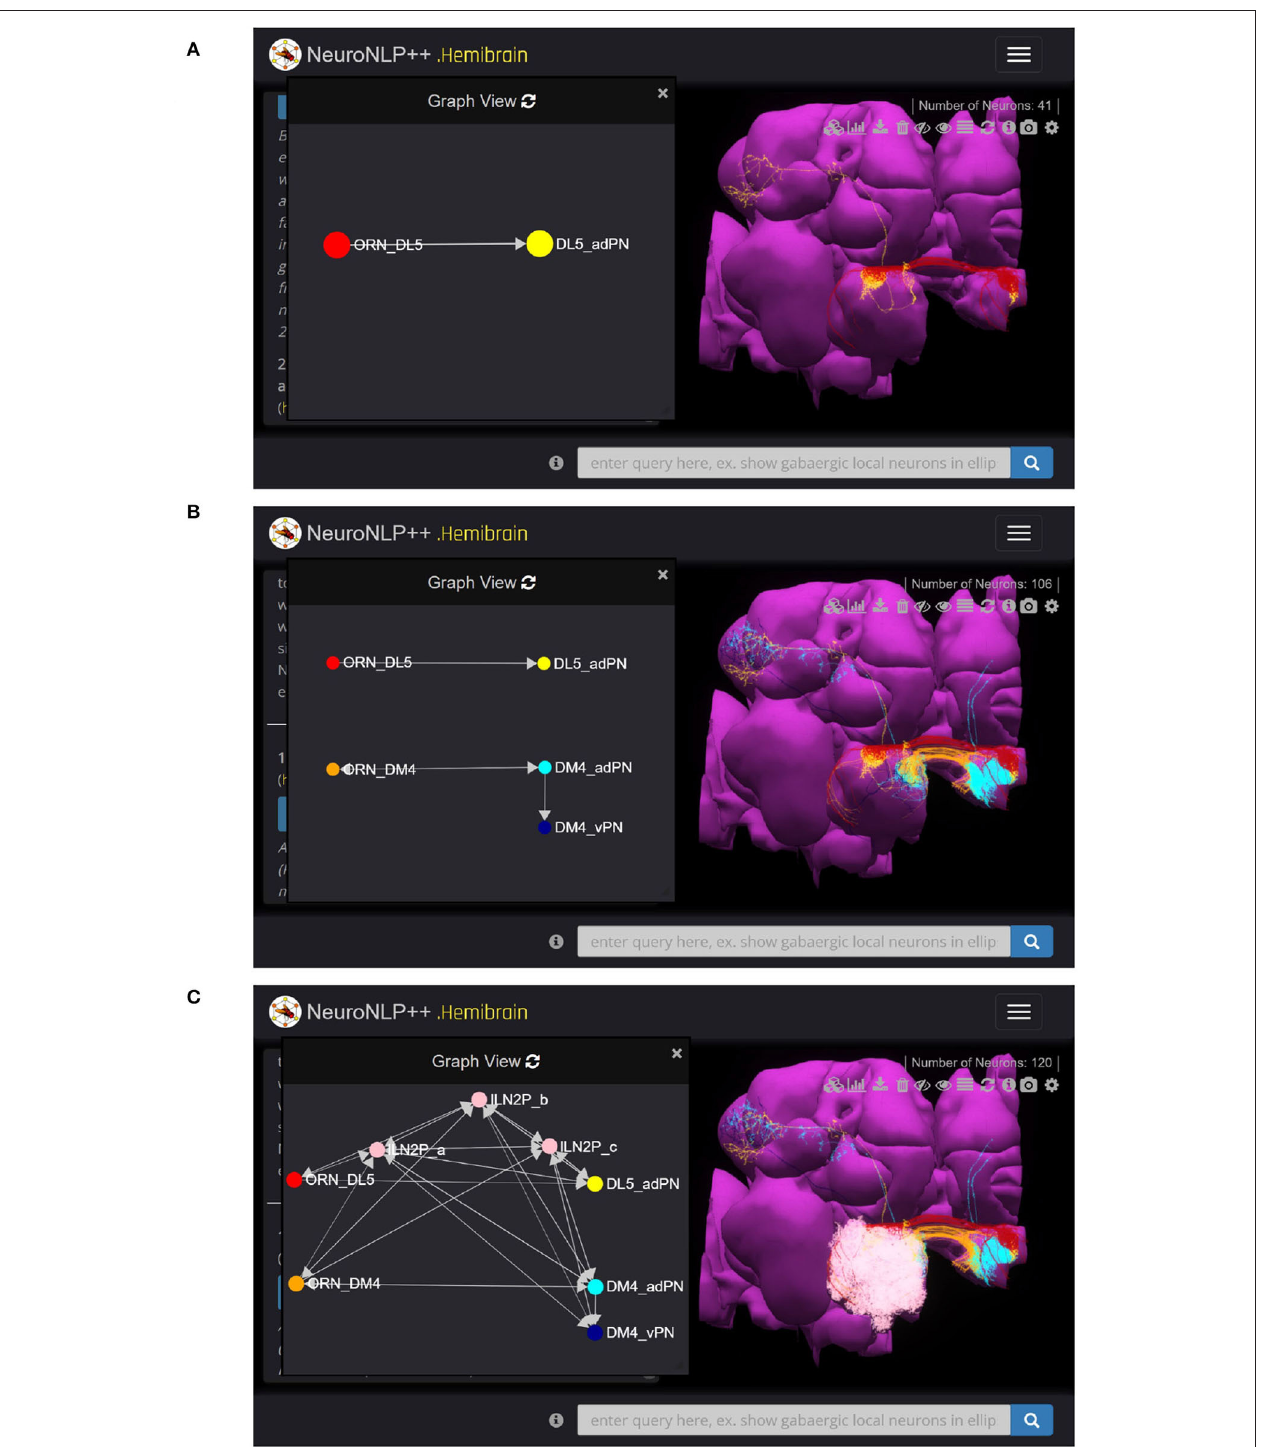
FIGURE 4 | Free-form English queries of the AL with NeuroNLP ++ . (A) Result to the query “what are the cell types of the DL5 glomerulus?”, consisting of the OSNs with axons that arborize the DL5 glomerulus (red) and the PN with dendrites in the DL5 glomerulus (yellow). (left) Cell type connectivity graph of the visualized neurons. (right) Morphology of the retrieved neurons. (B) Result to the query “what are the cell types of the DM4 glomerulus?”, in addition to (A) , consisting of the OSNs (orange with axons that arborize the DM4 glomerulus and the adPNs (cyan) and vPNs (blue) with dendrites in the DM4 glomerulus. (left) Cell type level connectivity graph of the resulting neurons. (right) Morphology of the retrieved neurons. (C) Results to the query “what are the patchy local neurons?”, in addition to (B) . The resulting LNs are in pink. (left) Cell type connectivity graph of the visualized neurons. (right) Morphology of the retrieved neurons.